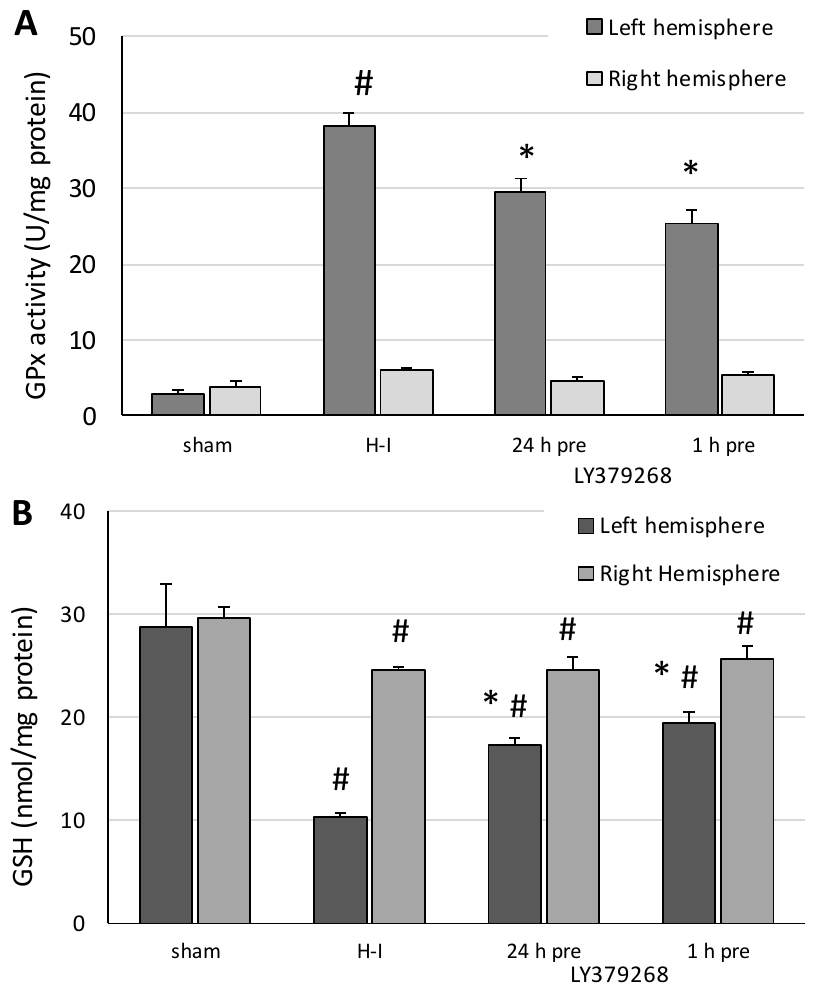
Figure 5. ( a ) The effect of LY379268 pretreatment on H-I-evoked changes in glutathione peroxidase activity and ( b) the level of glutathione. The results are presented as the mean ± SD, n = 3–5; #—significantly different from the sham-operated group, p < 0.005; *—significantly different from the H-I group, p < 0.005.